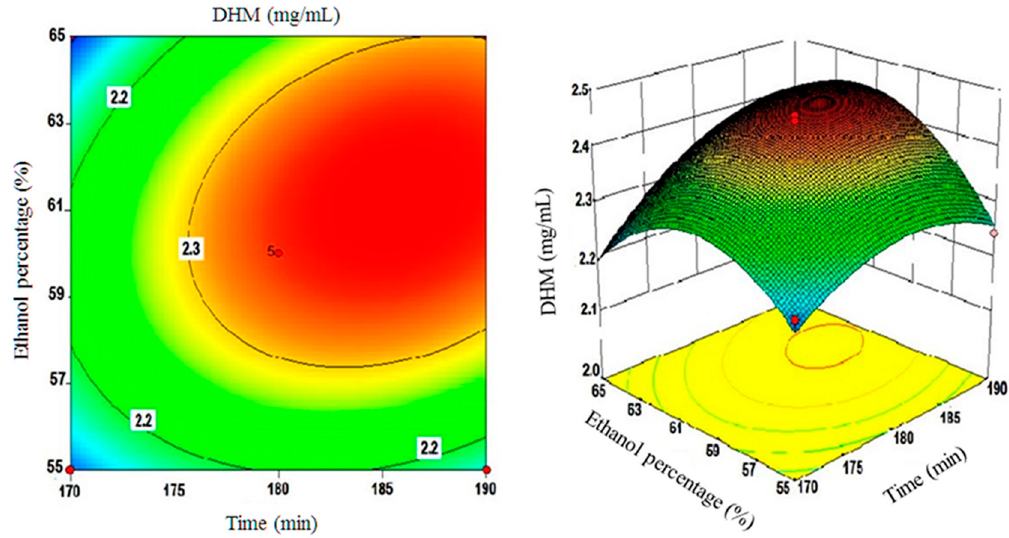
Figure 5. A 3D surface plot of ethanol (%) and extraction time(s) interactions and their effect on DHM yields (mg/mL).